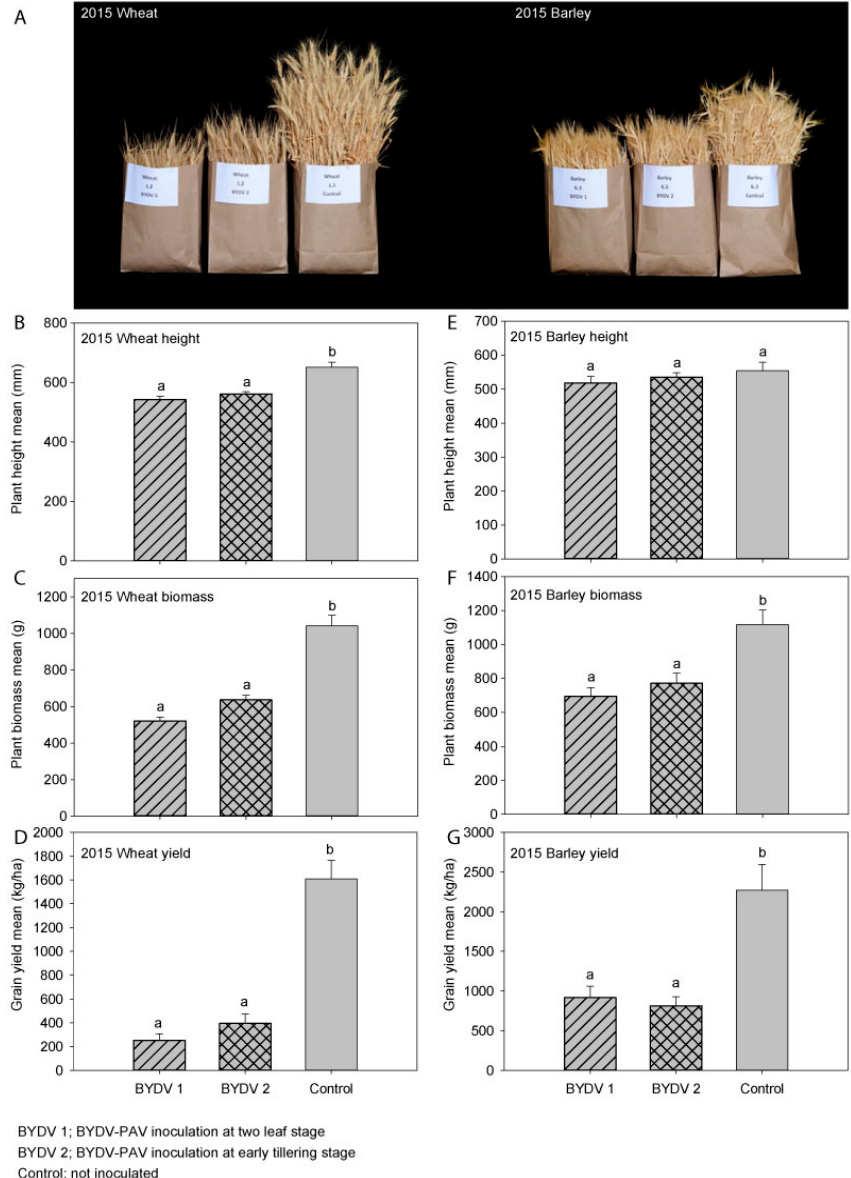
Figure 2. The effect of early (BYDV 1), later (BYDV 2), or no (Control) barley yellow dwarf vi- rus-PAV (BYDV-PAV) inoculation on: ( A ) plant growth of wheat (left) and barley (right); ( B ) plant height; ( C ) plant biomass; ( D ) grain yield of wheat in experiment 1 (2015) and ( E ) plant height; ( F ) plant biomass; ( G ) grain yield of barley in experiment 2 (2015) in South-Eastern Australia. Error bars represent standard error; means with the same letter are not significantly different at p < 0.05.